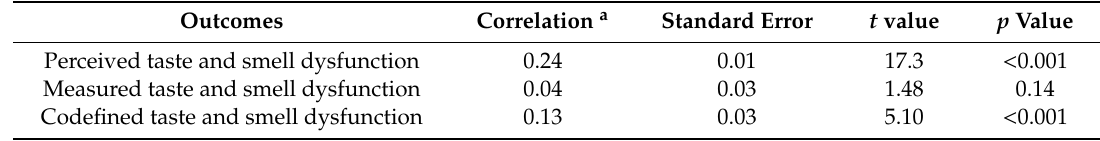
Table 4. Correlations between taste dysfunction and smell